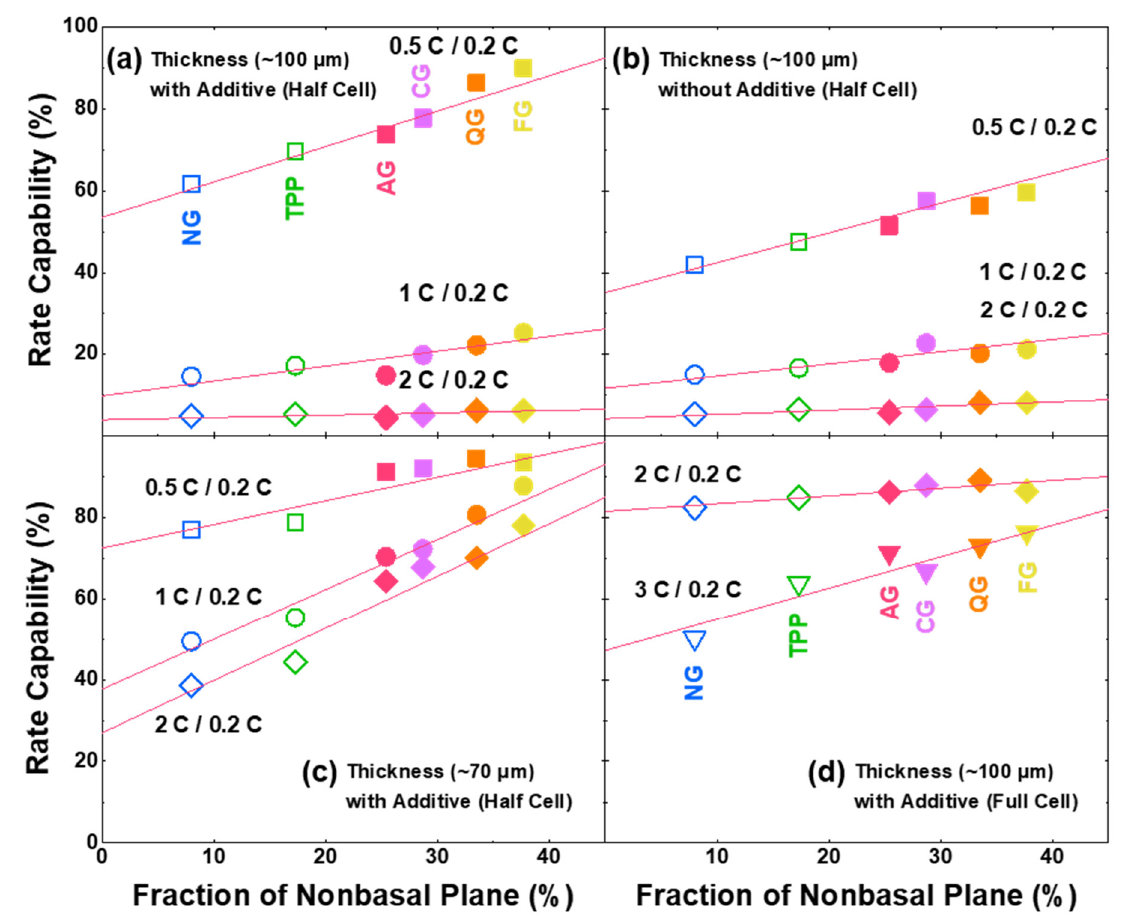
Figure 3. Correlations between fraction of non-basal plane and fast-charging capability with coin cells. Half-cell conditions: ( a ) ~100-μm thick electrode with electrolyte additive, ( b ) ~100-μm thickness without electrolyte additive, and ( c ) ~70-μm thickness with electrolyte additive. ( d ) Full-cell condition: ~100-μm thick graphite electrode with electrolyte additive and LiNi 0.88 Co 0.10 Al 0.02 O 2 (NCA)